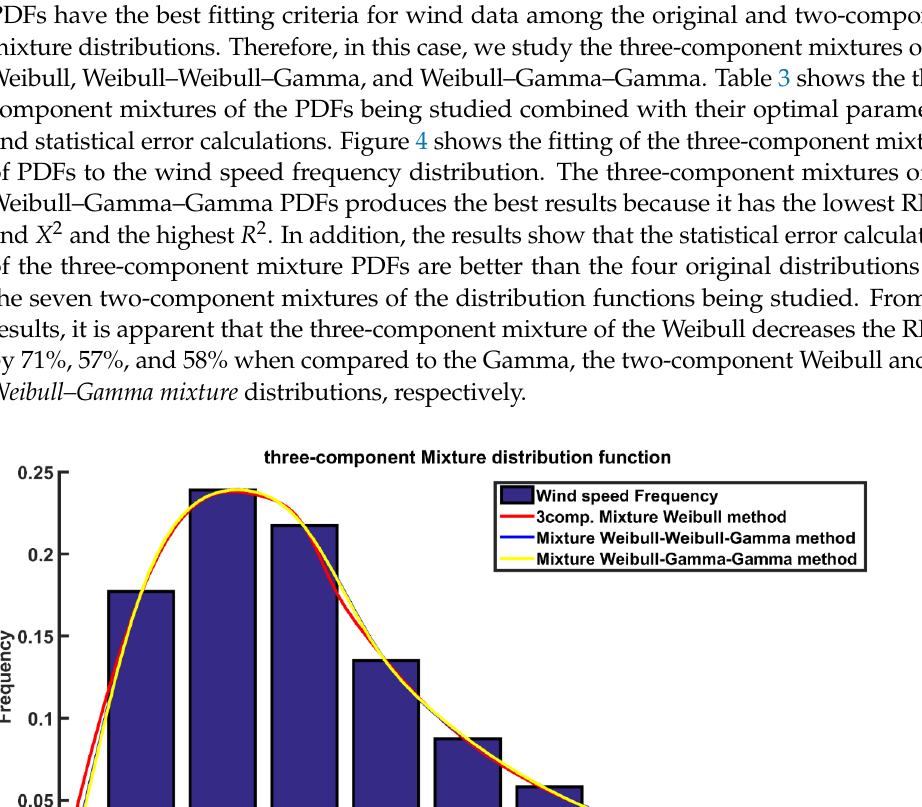
Figure 4. The three-component mixture distribution functions in wind speed modeling.